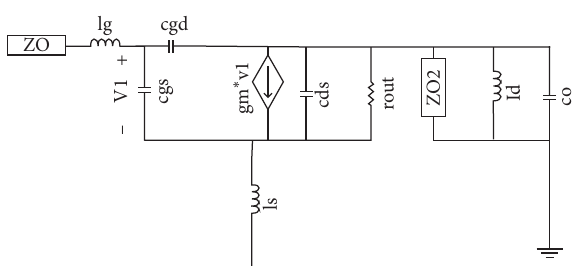
Figure 6: The equivalent circuit of common-source LNA.